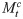
Time series, by treatment, of the segregation levels of colour Mtc (black), and tolerance Mtf (yellow), filtered by extreme values of the native-share initial condition (0.3 ≤ NatShare ≥ 0.7).The error bars show the 95% confidence intervals of the mean of Mt across simulation runs. The dashed line at tmig marks the end of migration waves.